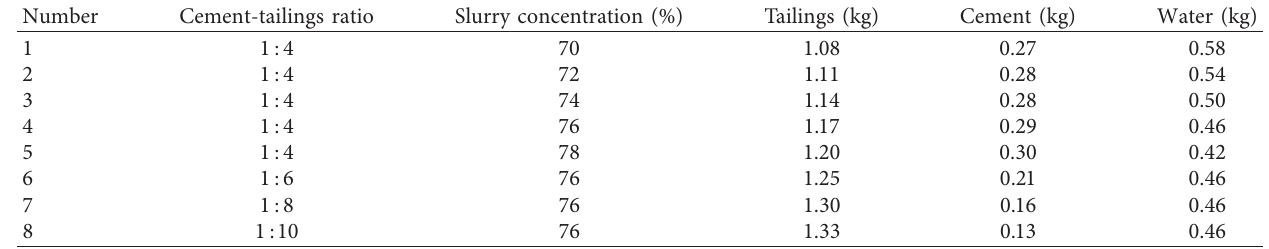
Figure 2: Material characteristics of tailings. (a) Particle size distribution of tailings; (b) X-ray fluorescence pattern of Table 1: Composition of filling slurry.